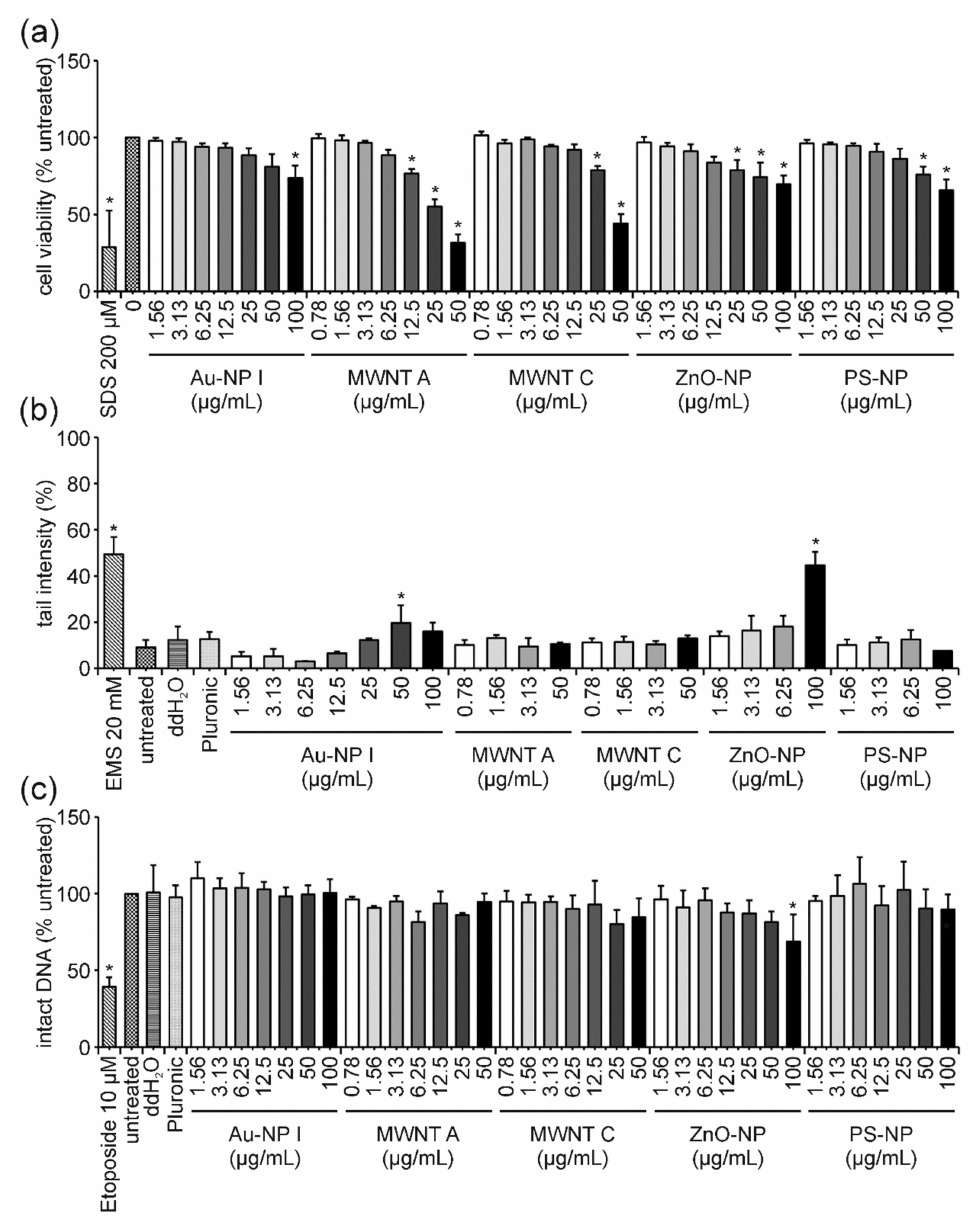
Figure 3. Influence of Au-NP I, MWNT A, MWNT C, ZnO-NP and PS-NP on Jurkat E6-I cell viability and DNA damage induction after 3 h of incubation . Following incubation of Jurkat E6-I cells with different concentrations of Au-NP I, MWNT A, MWNT C, ZnO-NP and PS-NP for 3 h, cell viability was determined by MTT assay ( a ). As a positive control, cells were incubated with 200 µ M SDS (3 h). DNA damage expressed as tail intensity percentage was assessed by alkaline comet assay ( b ). EMS (30 min) served as the positive control. The FADU assay was performed as a second method for genotoxicity assessment ( c ). Treatment with etoposide (30 min) served as the positive control. Results represent the mean and corresponding standard deviations from at least three independent experiments. (* p ≤